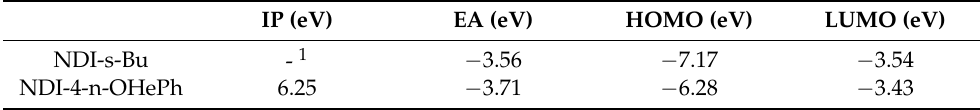
Table 1. Experimentally measured IP and EA and theoretically predicted HOMO and LUMO energies.